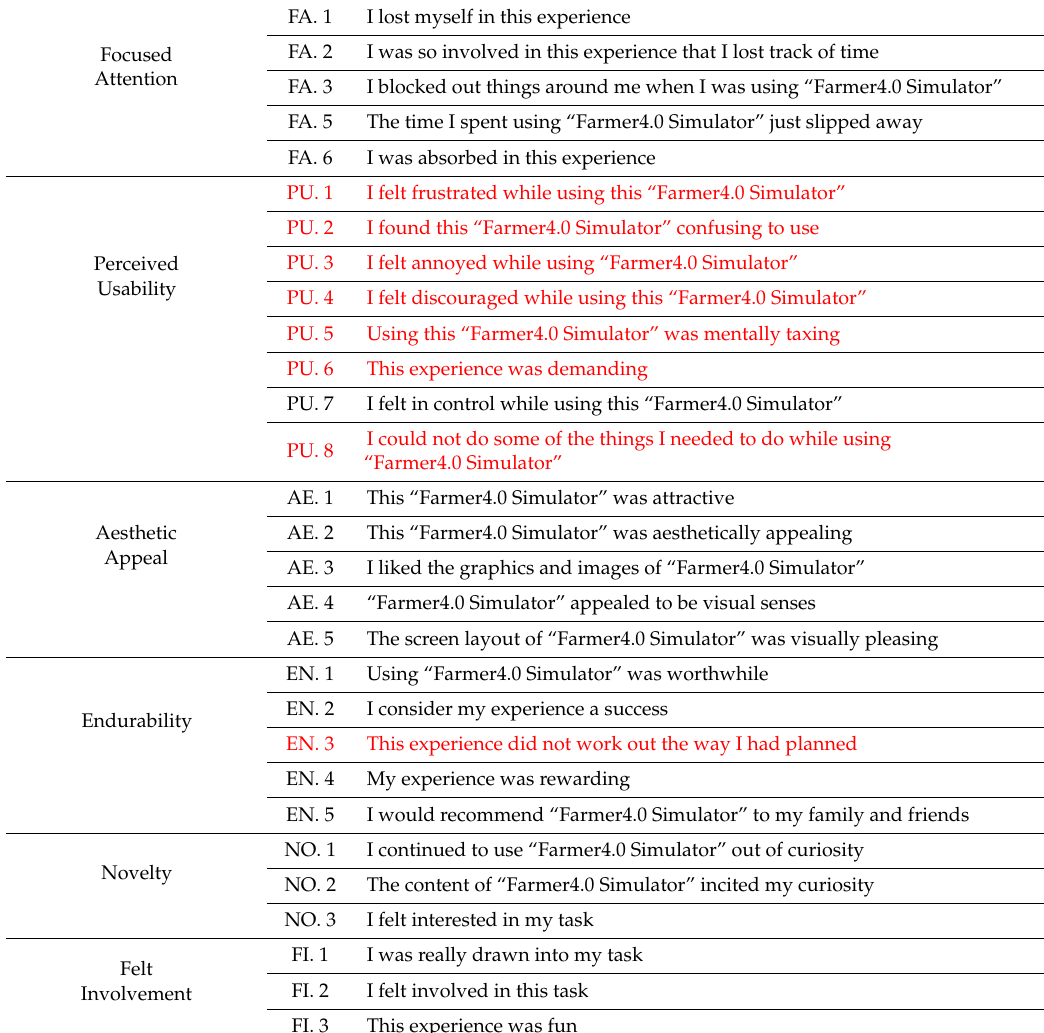
Table 1. The 29-items of the User Engagement Scale (UES) questionnaire divided into the six dimensions of engagement: focused attention (FA), perceived usability (PU), aesthetic appeal (AE), endurability (EN), novelty (NO), and felt involvement (FI). The negative closed-ended questions are highlighted in